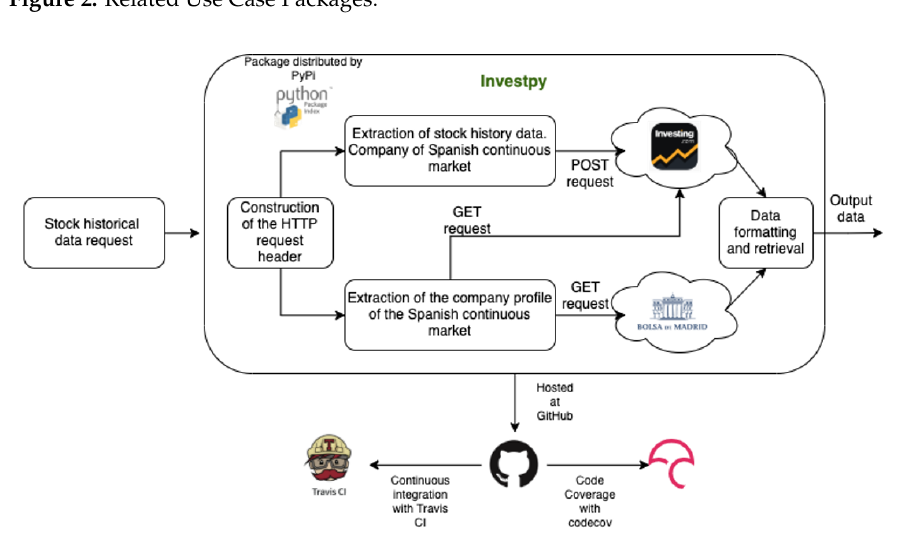
Figure 3. Data extraction Package Design